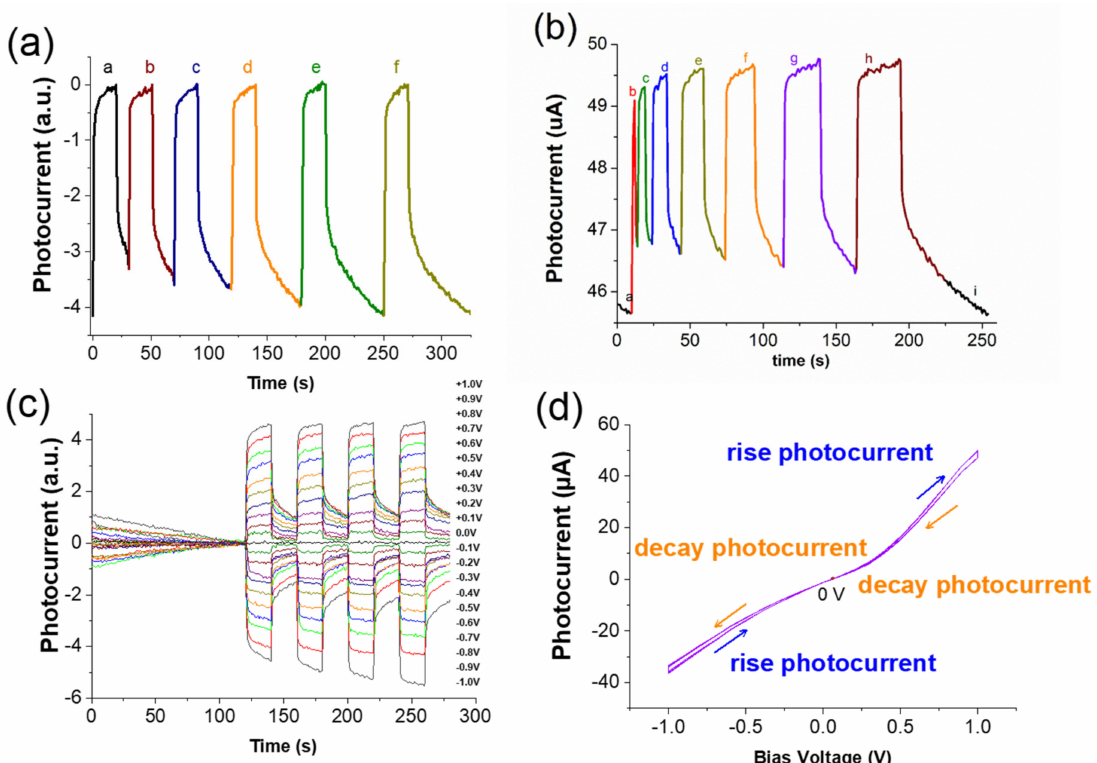
Figure 5. Component characteristic analysis: ( a ) the light time is 20 s, and the light is turned off for a. 10 s, b. 20 s, c. 30 s, d. 40 s, e. 50 s, f. 60 s. ( b ) a. photocurrent background value, b. turn on/off the light for 1 s, c. 5 s, d. 10 s, e. 15 s, f. 20 s, g. 25 s, h. 30 s, i. turn on/off 30; it takes another 30 s to decay the current to return to the original background value after seconds; ( c ) the original element photocurrent-time graph; and ( d ) the original element photocurrent-voltage